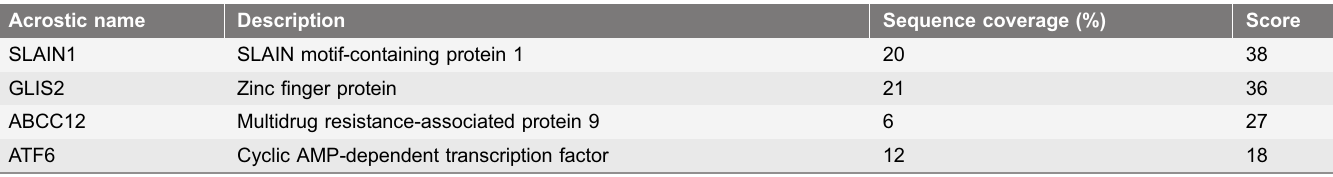
Table 5. Mascot search result for BRAF mutated vs BRAF wt